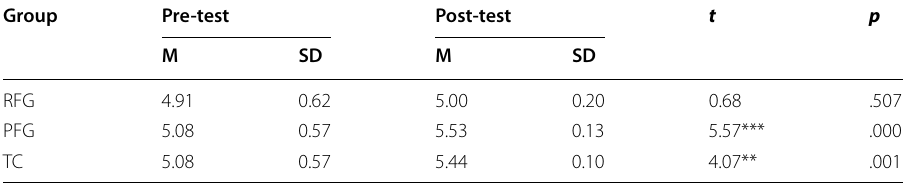
Table 4 Results of the paired-sample t -test Group